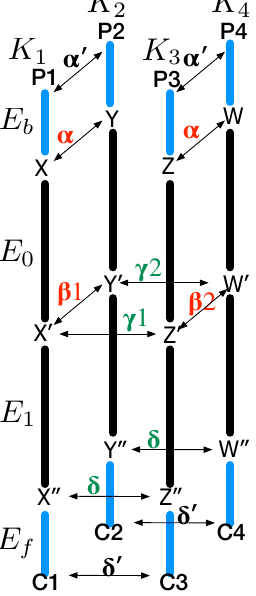
Figure 8: Key recovery model of related-tweakey rectangle